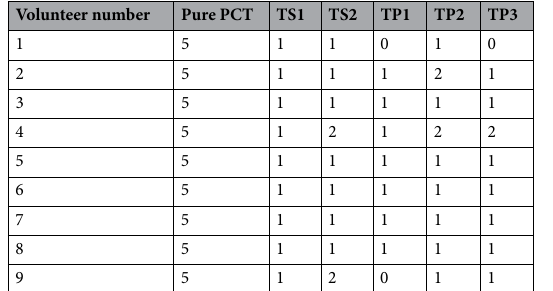
Table 4. Gustatory evaluation scores of trials for In vivo evaluation of PCT taste masking.